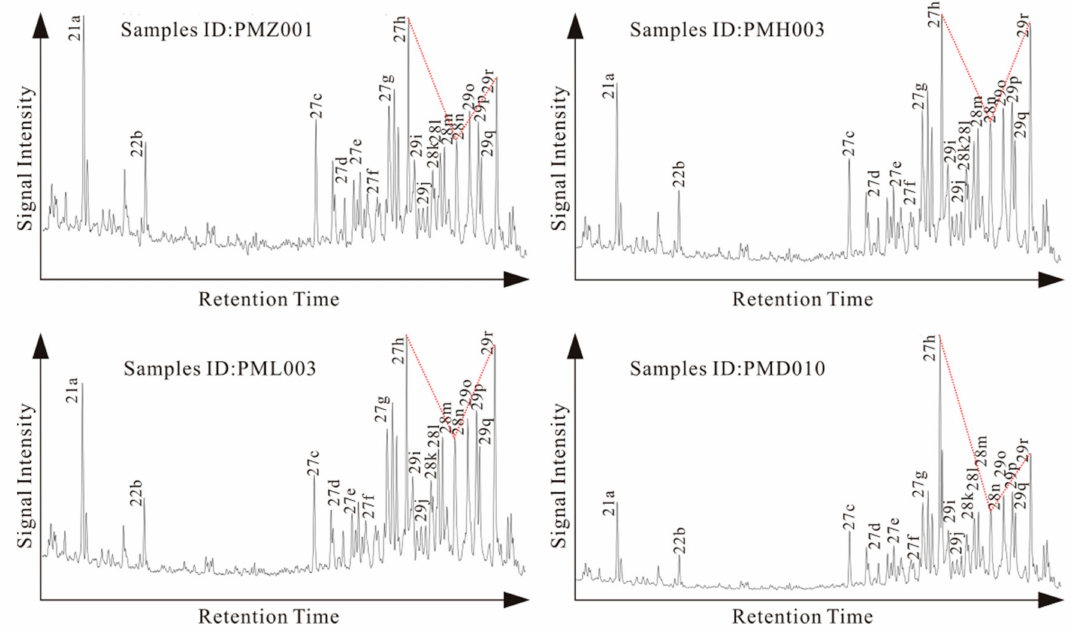
Figure 7. M/z217 mass fragment grams of saturated hydrocarbon